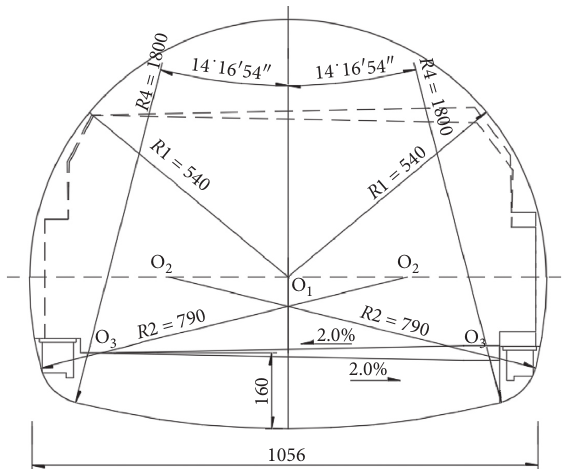
Figure 1: Typical cross-section for Dugongling tunnel (unit: cm).